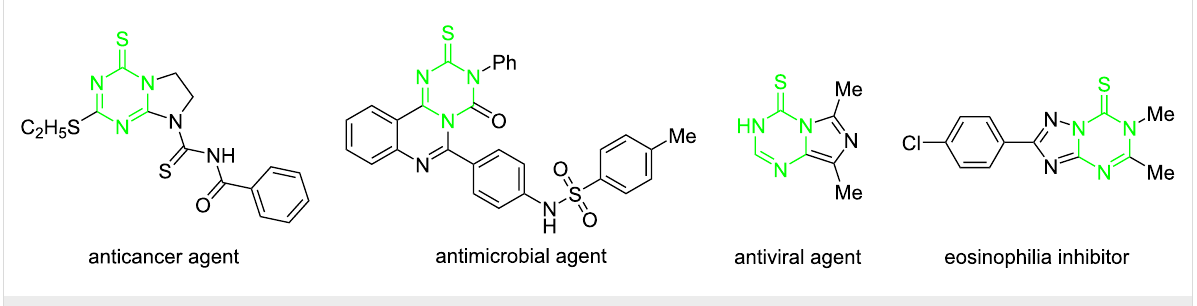
Figure 1: Selected examples of triazinethione-containing bioactive compounds.